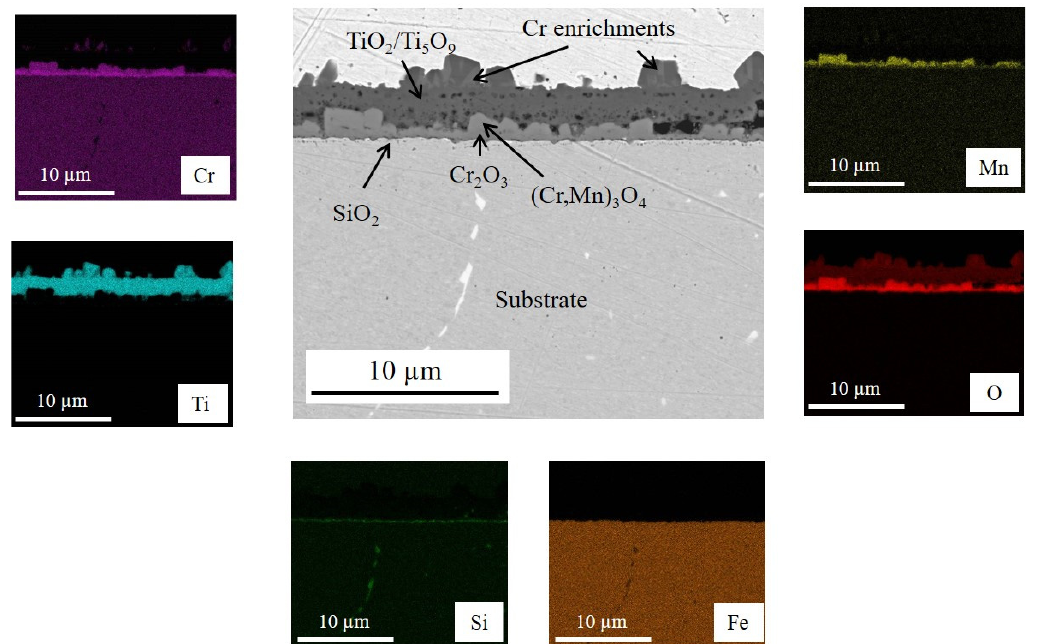
Figure 12. Backscattered electron image and EDX elementary maps of the cross section of the Ti-coated pre-oxidized sample after 100 h aging at 800 °C under laboratory air.